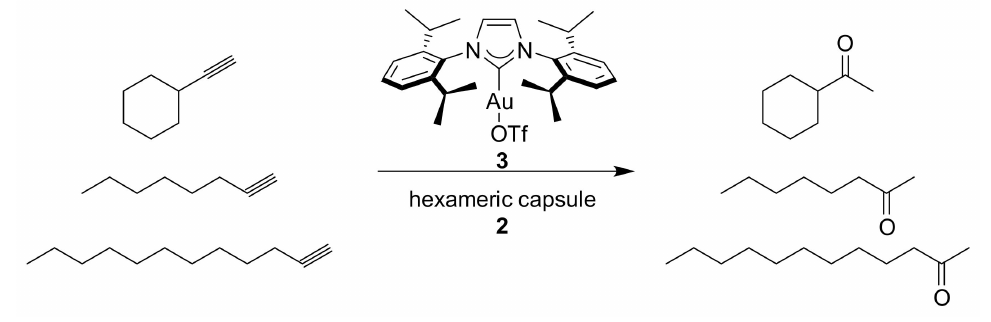
Scheme 1. Hydration of terminal alkynes catalyzed by catalyst 3 included into capsule 2 .